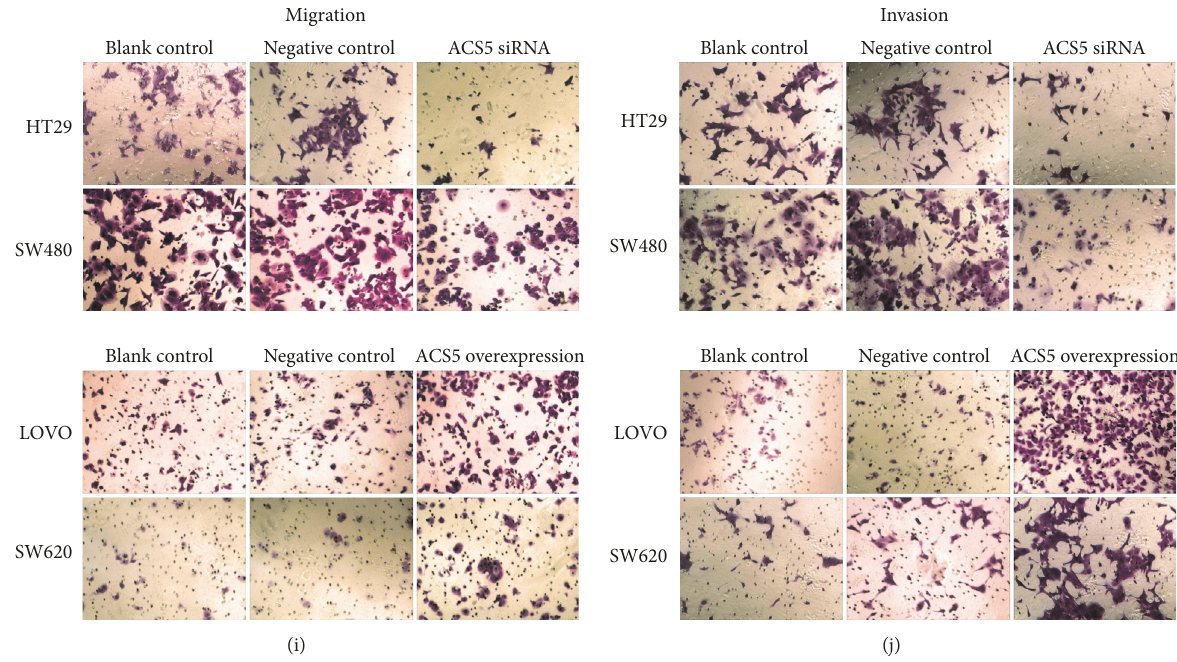
Figure 6: Effect of ACS5 on the migration and invasion of CRC cells. ((a)–(d), (i)) Analysis of migration capability of CRC cells. ((e)–(h), (j)) Analysis of invasion capability of CRC cells. Both the migrated and invaded number of HT29 and SW480 cells with ACS5 knockdown were significantly decreased compared with negative control or blank control. Inversely, both the migrated and invaded number of LOVO and SW620 cells with ACS5 overexpression were remarkably increased compared with negative control or blank control. ∗∗ 𝑃 < 0.01 versus negative control or blank control